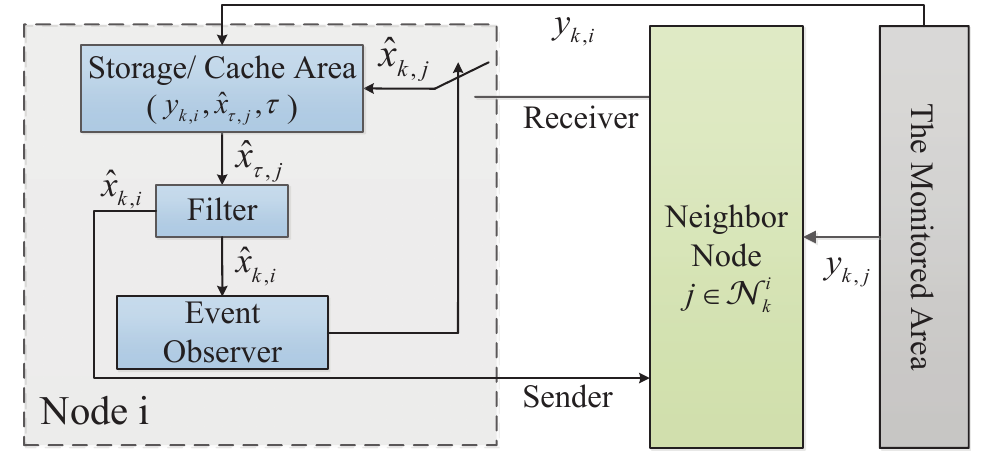
Figure 2. Diagram of the event-triggered